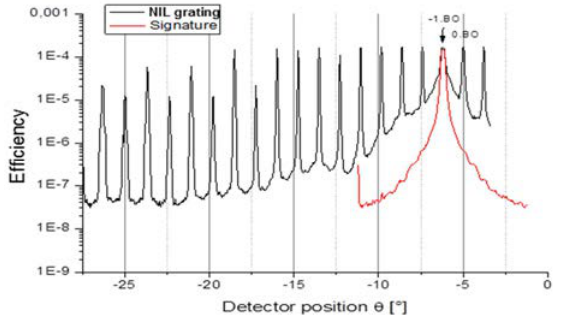
Fig. 7. Angular scanning of the efficiency in the diffractive plane at 633 nm for the NIL